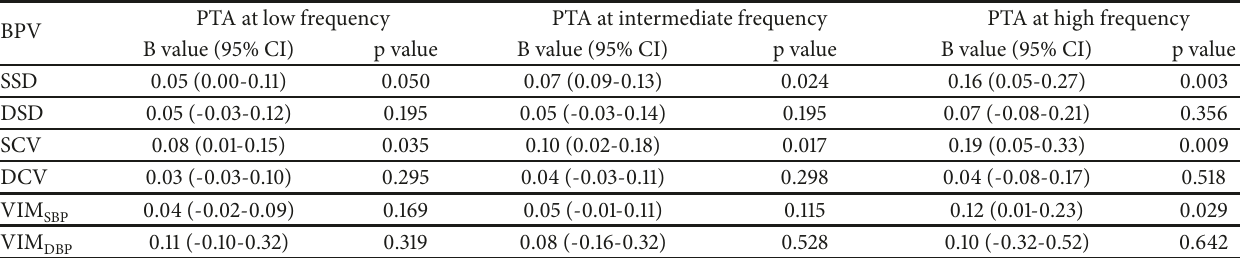
Table 3: Multivariate linear regression analysis between BPV and PTA.